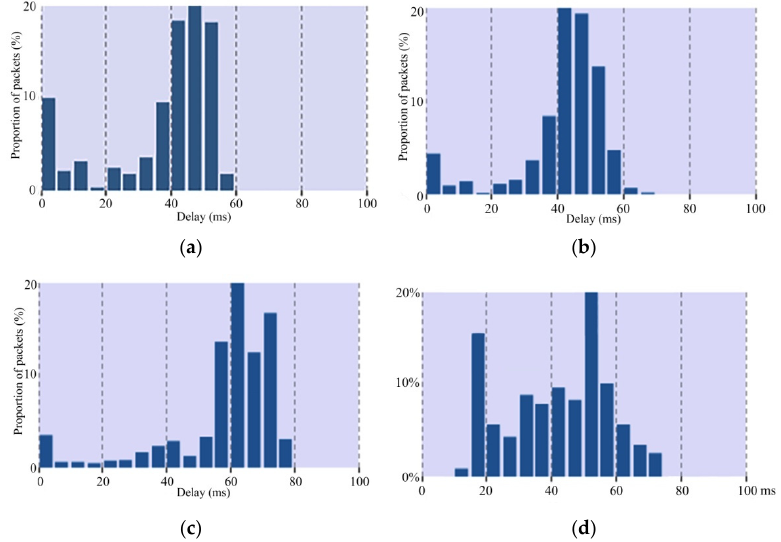
Figure 3. Simulation results of the blockchain node system: ( a ) Dependence of the proportion of packets on the waiting time for processing at the access node; ( b ) dependence of the proportion of packets on the delay at the access node; ( c ) dependence of the proportion of packets on the waiting time for processing at the aggregation node; ( d ) dependence of the proportion of packets on the delay at the aggregation node